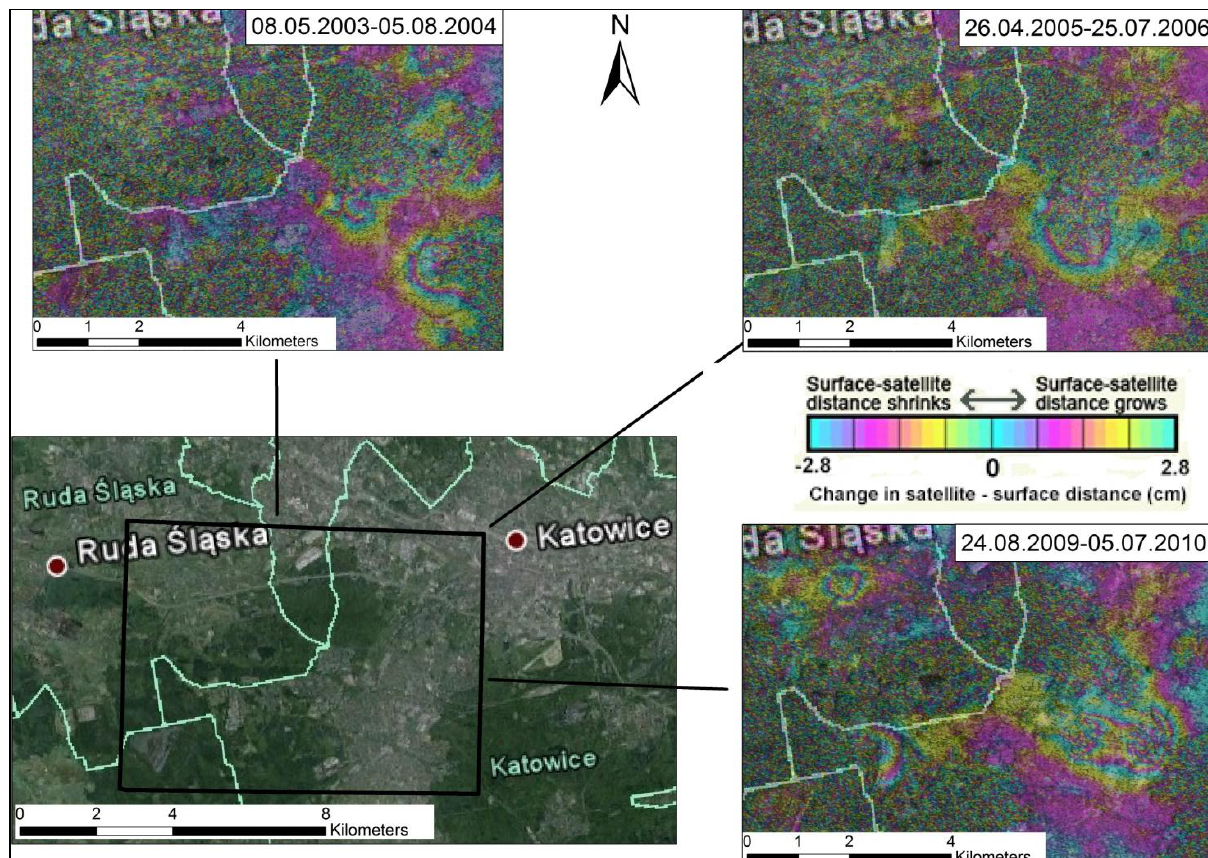
Fig. 4. Large subsidence detected with larger Btemp ~in a year time range in Ruda Śląska, used images: Envisat